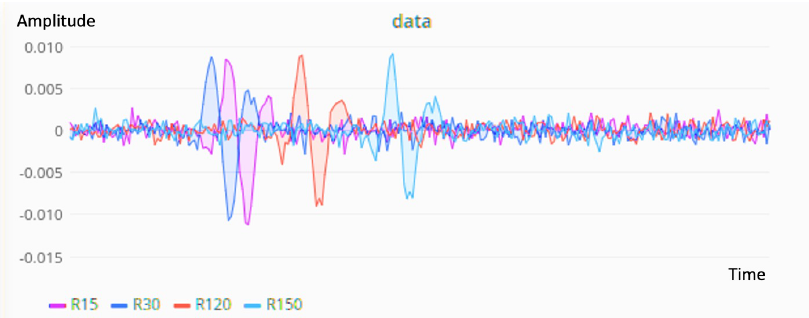
Figure 9. Real-time visualization of seismic data recorded on different